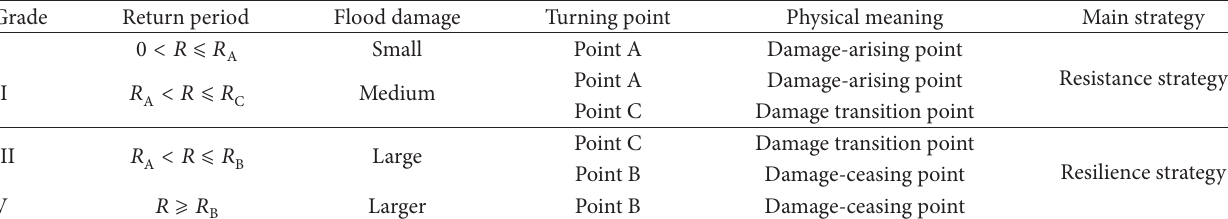
Table 6: The grades of flood hazards and main